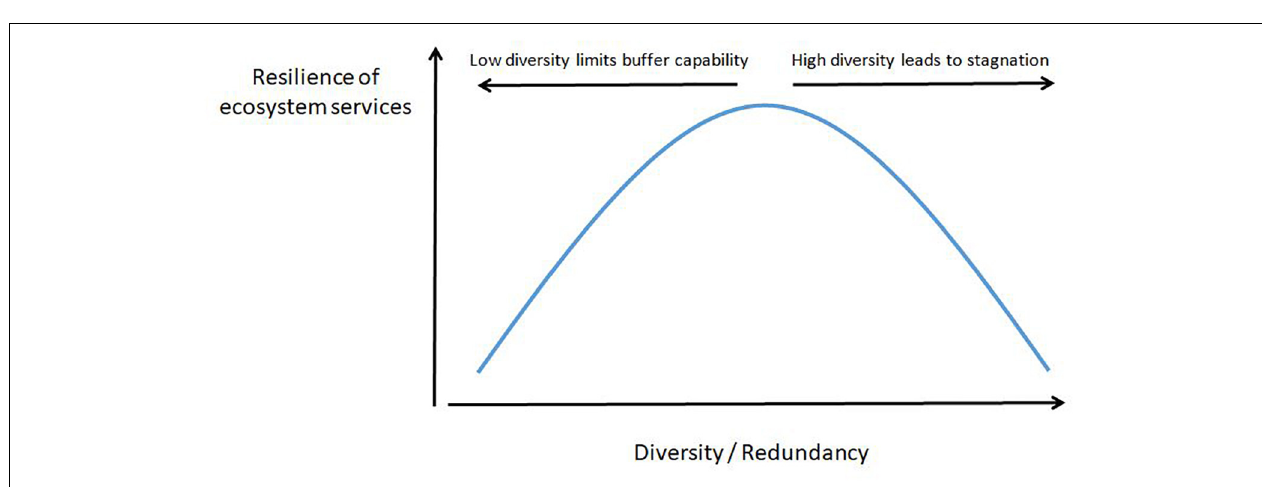
FIGURE 6 | Theoretical relationship between system diversity/redundancy and the resilience of ecosystem services [adapted from Biggs et al. (2012)]. The shape of this curves suggests an optimum beyond which system resilience would be compromised by the level of APS diversity and interactions.